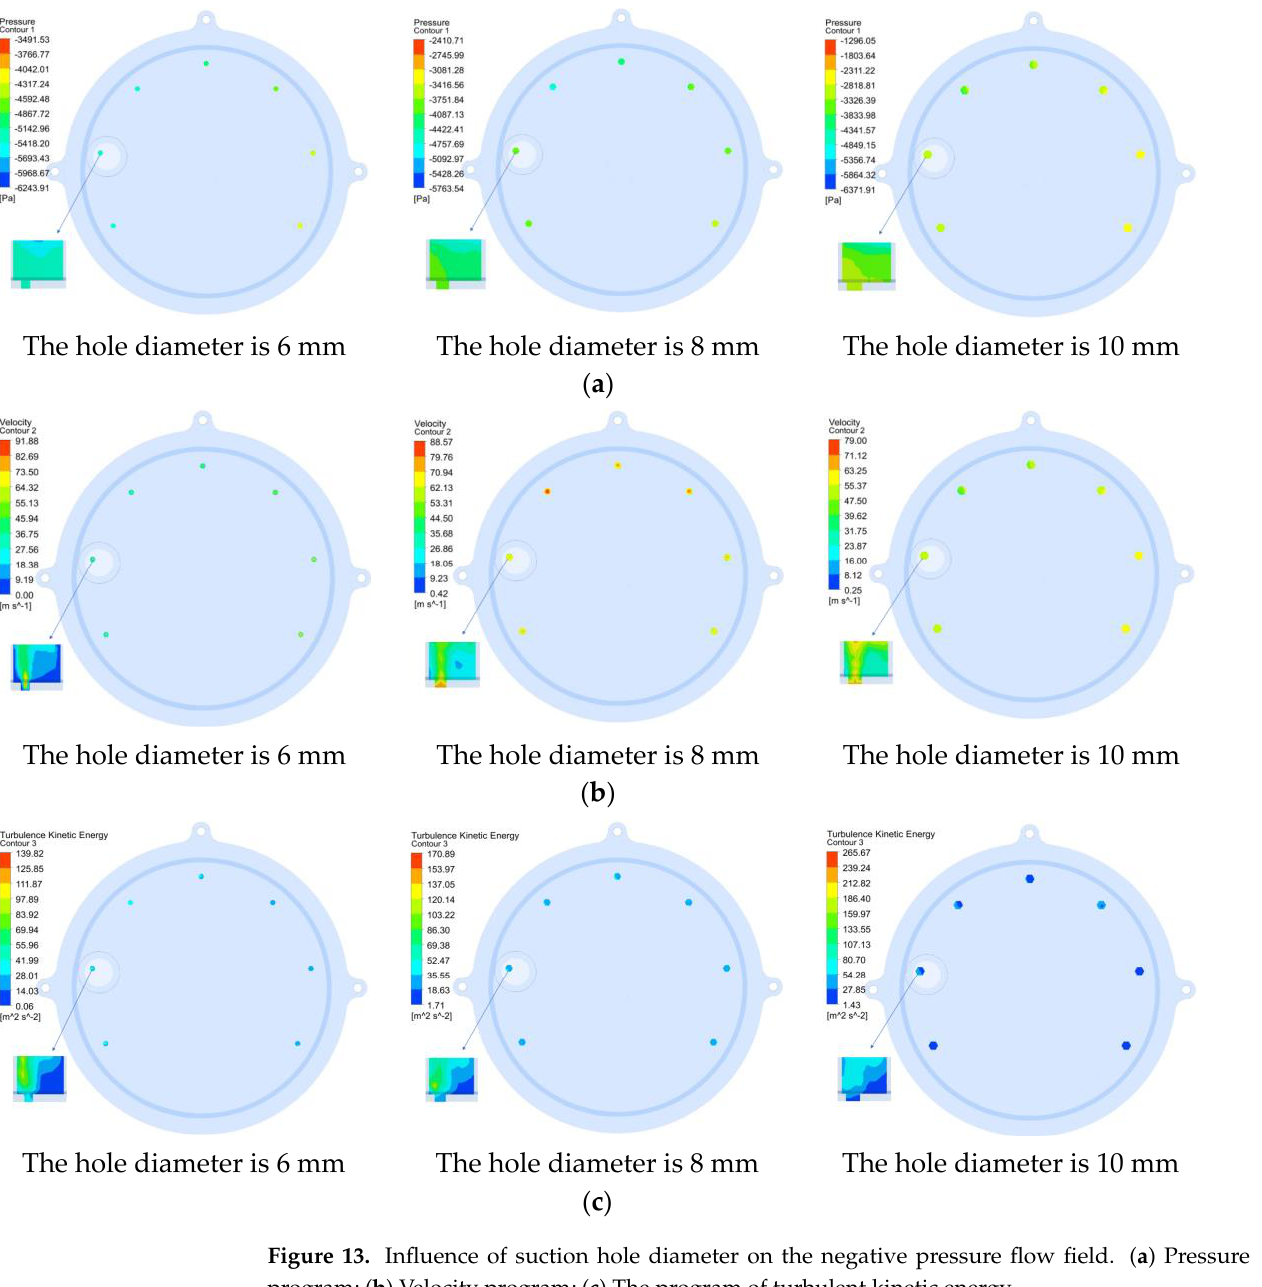
Figure 14. Test bench of Seeding performance experiments. To test the seeding performance of this device, 250 consecutive garlic seeds were ran- domly selected for each group of tests to measure statistics and repeated three times. The test results were averaged and recorded. Since the pass rate + missed seeding rate + re- seeding rate = 100%, two of them are known to obtain the third one, so the pass rate 𝑌 1 and missed the seeding rate 𝑌 2 were selected as evaluation indicators to measure the seed- ing performance. The evaluation index formula [33] is as follows. 𝑌 1 = 𝑚 1 𝑀 ′ × 100%